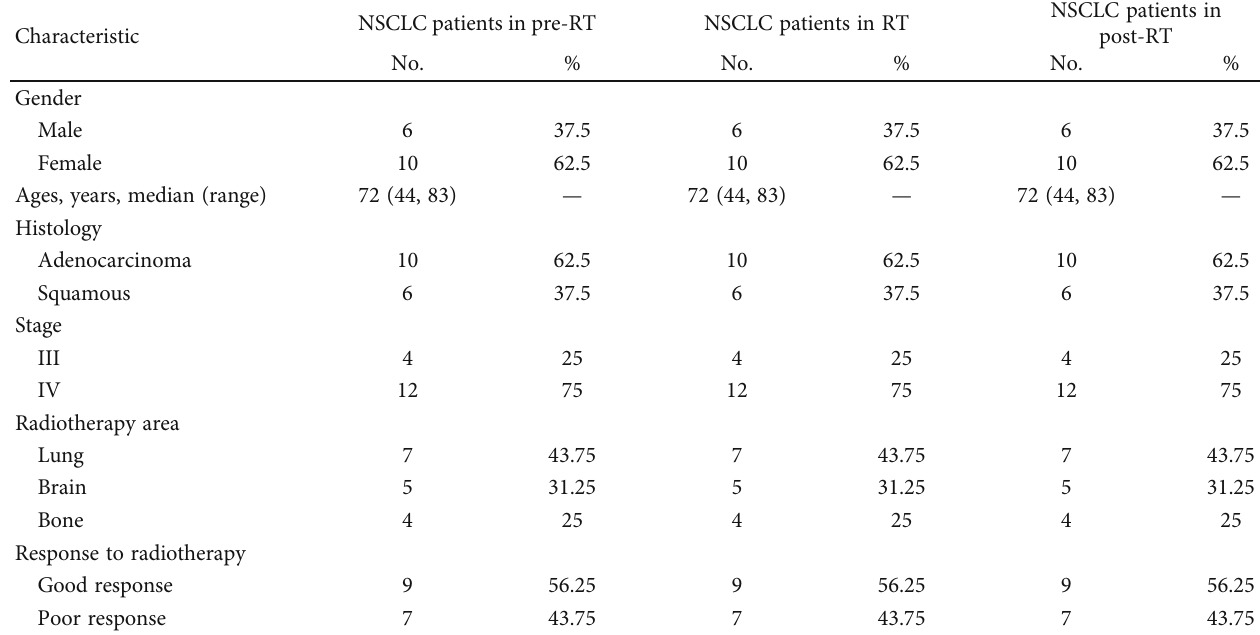
Table 1: Clinical characteristic of NSCLC patients in di ff erent stages of